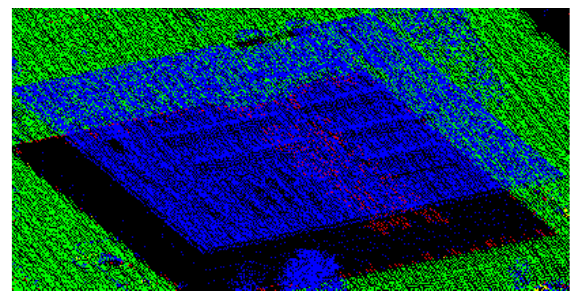
Figure 10. Error on point clouds inside building (red points) Another error source is points inside buildings as seen in Figure 10. Due to the point cloud density, many laser pulses penetrated inside building through the small gaps on the roof, window, or wall. It can be seen many points inside building on the ground floor. Those points were misclassified as ground. This error is due to the similarity between the elevation of those points and the surrounding terrain. If this is considered to be a problem, manual editing using building footprints is